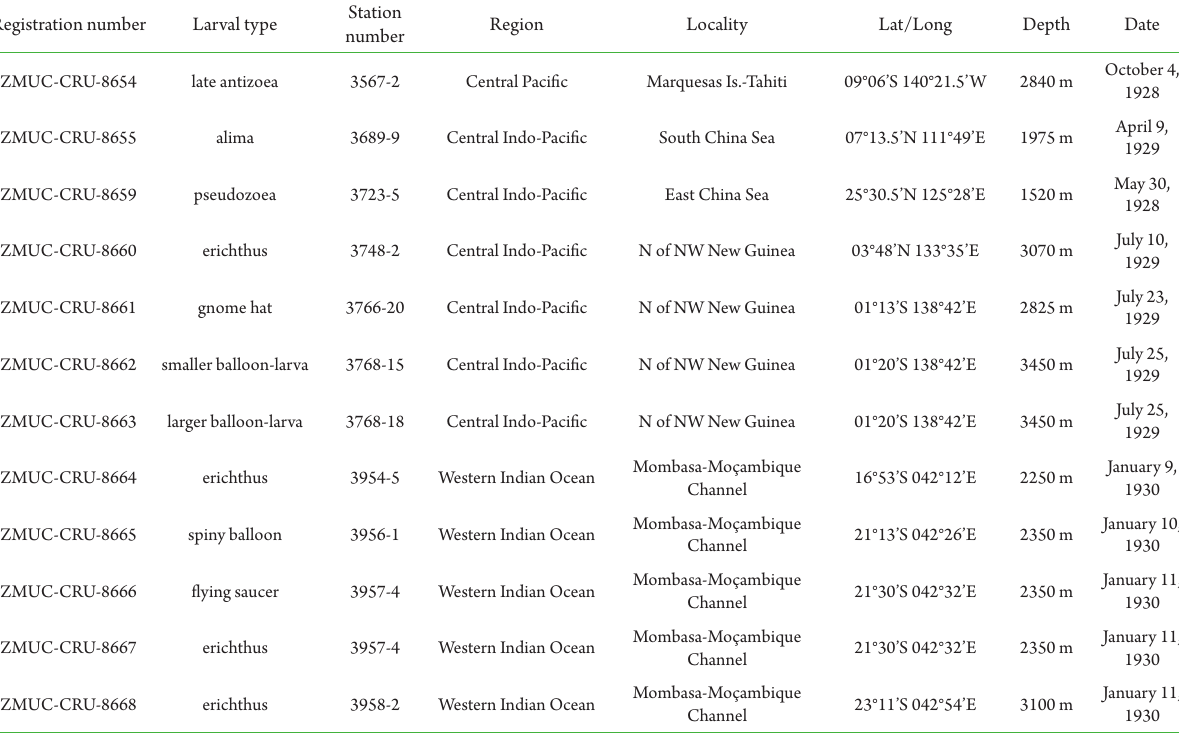
Table 1. Original localities of the specimens, all from pelagic samples, and additional data from the “Dana” II expedition